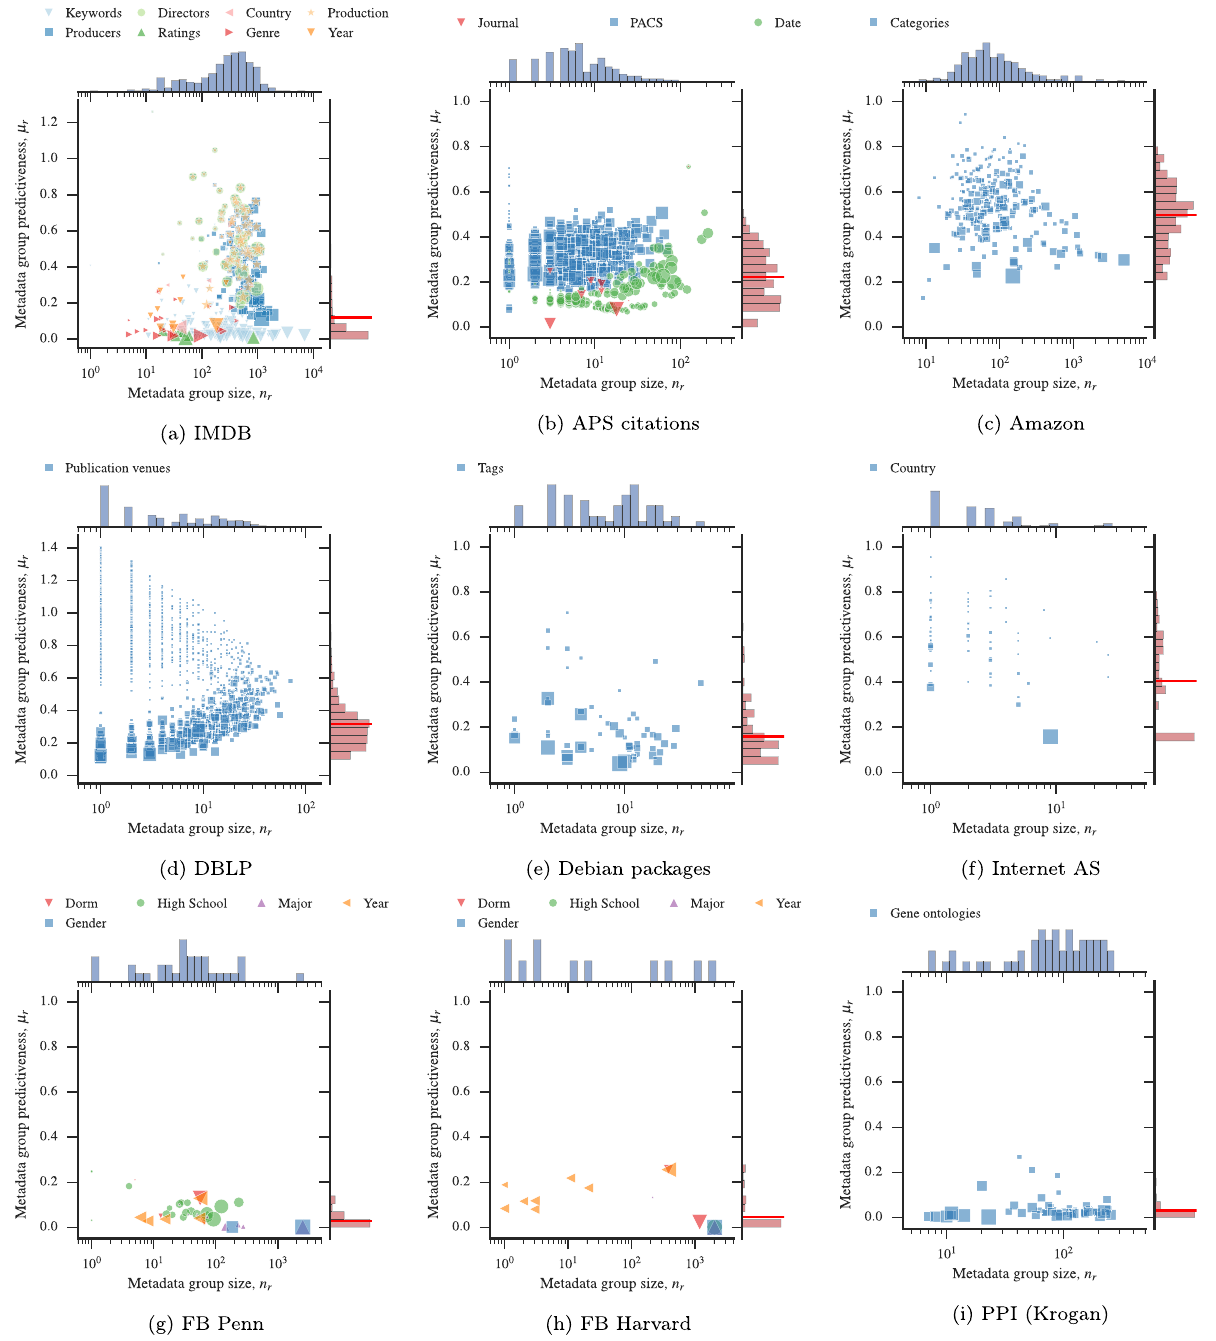
FIG. 5. Metadata predictiveness for several empirical data sets. The panels show the predictiveness of metadata groups μ r [Eq. (18)] versus metadata group sizes n r .The sizes of the symbols indicate the metadata frequency. The symbols correspond to the most frequent types of tags in each group (which may contain tags of different types). On the axis of each figure are shown marginal histograms, weighted according to the tag frequencies. A red horizontal line marks the average